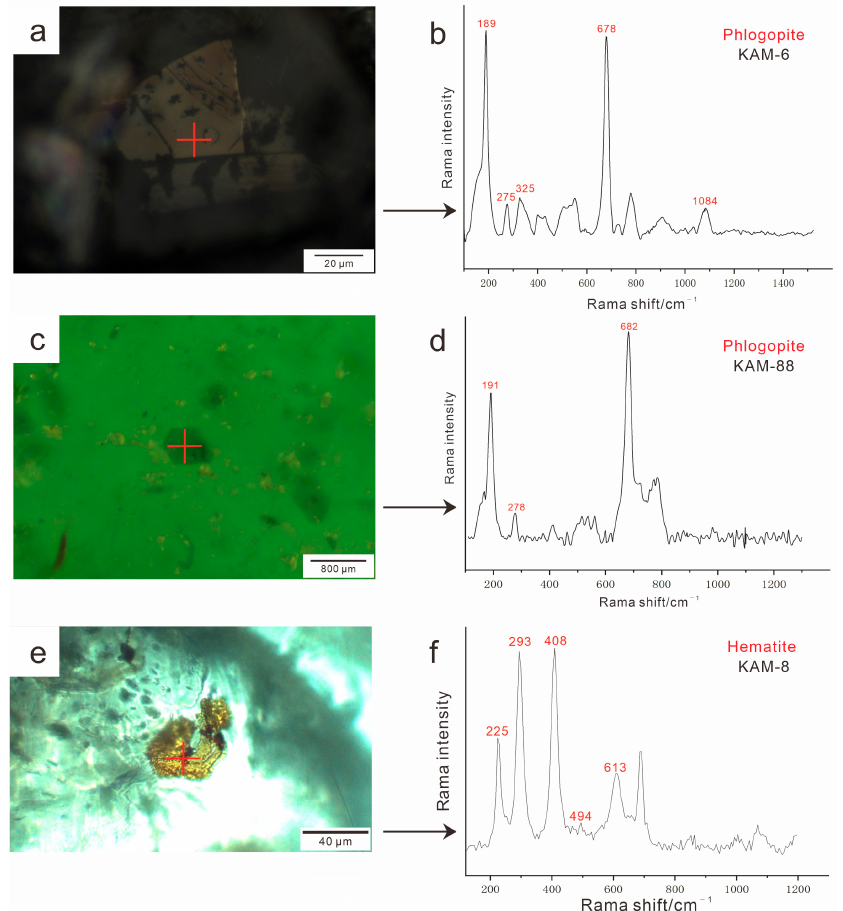
Figure 7. ( a ) Phlogopite inclusion in a Kamakanga emerald (KAM-6) and ( b ) its Raman spectrum. ( c ) Phlogopite inclusion in Kamakanga emerald (KAM-88) and ( d ) its Raman spectrum. ( e ) Hematite inclusion in Kamakanga emerald (KAM-8) and ( f ) its Raman spectrum.